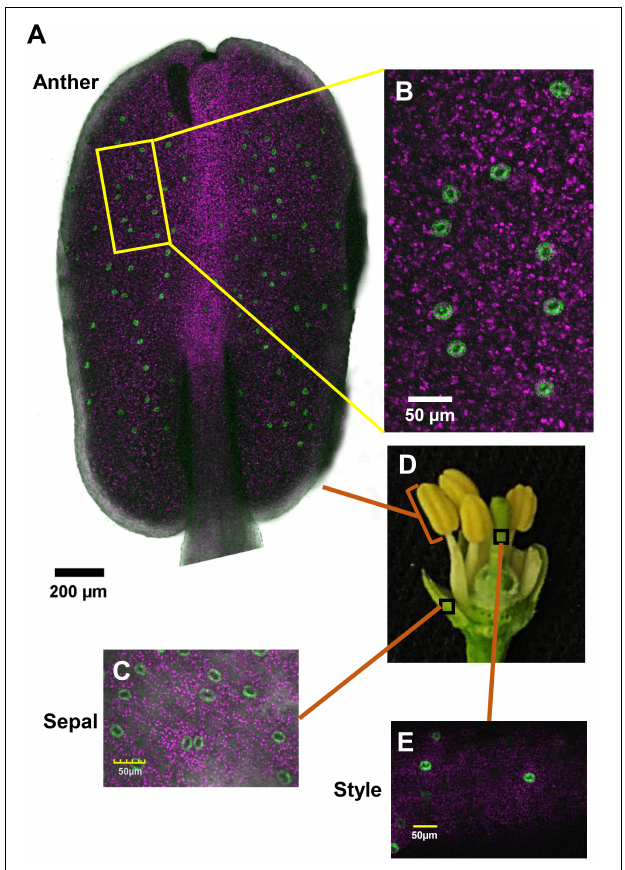
FIGURE 1 | Distribution of stomata on the organs of a closed citrus flower. The confocal images A–C and E are merged images of white light, chlorophyll autofluorescence (stained magenta), and GFP fluorescence (stained green). Flowers were harvested from GCGFP plants. (A) Confocal image of an anther removed from a closed flower. (B) Enlargement of the square in part A . (C) Confocal image of a sepal removed from a closed flower, as indicated in part D . (D) Dissection of a closed flower revealing the floral organs. (E) Confocal image of a style removed from a closed flower. Analyses were performed on five biological